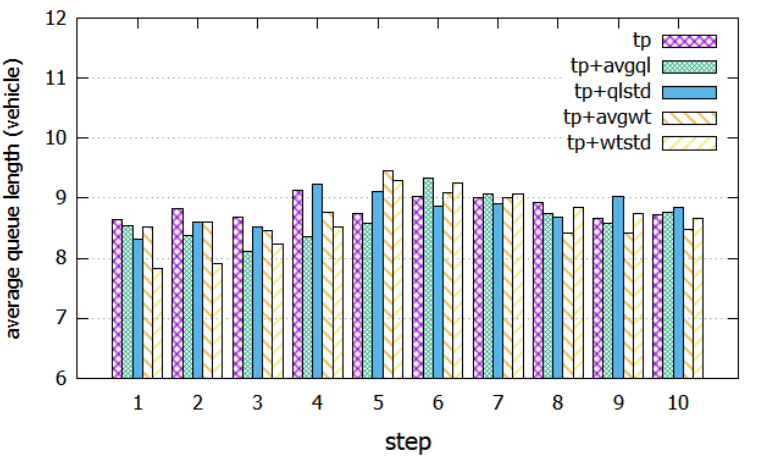
Figure 3. Performance of a technique for determining the green light duration of a phase in terms of the average queue length.